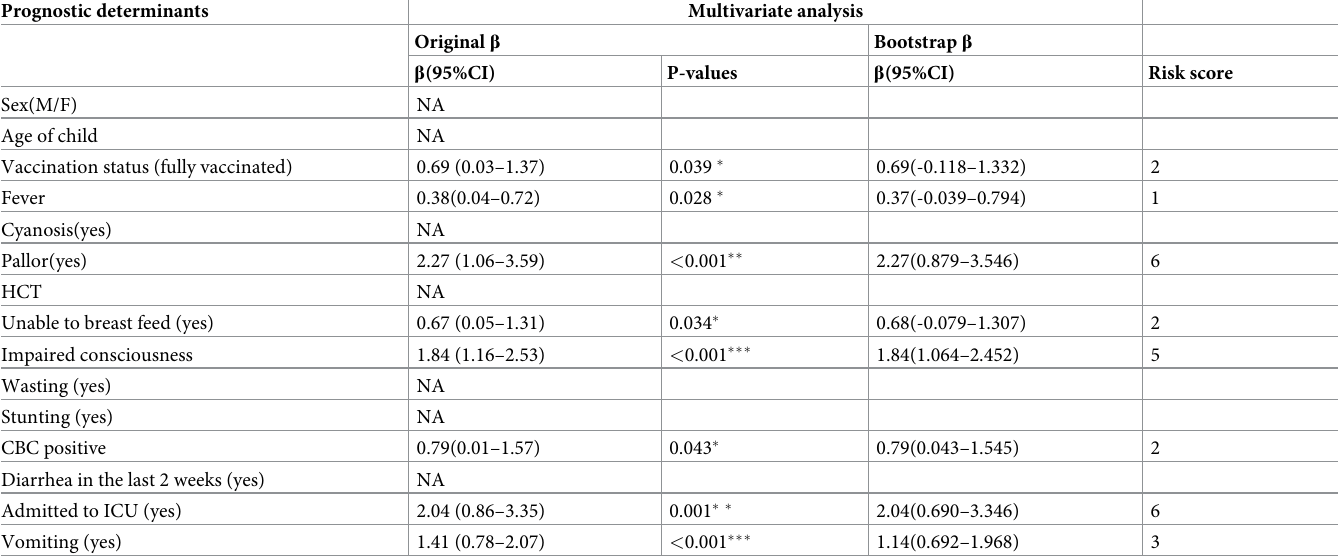
Table 3. β Coefficients and risk-scores of prognostic determinates to predict poor outcomes of pneumonia in children.